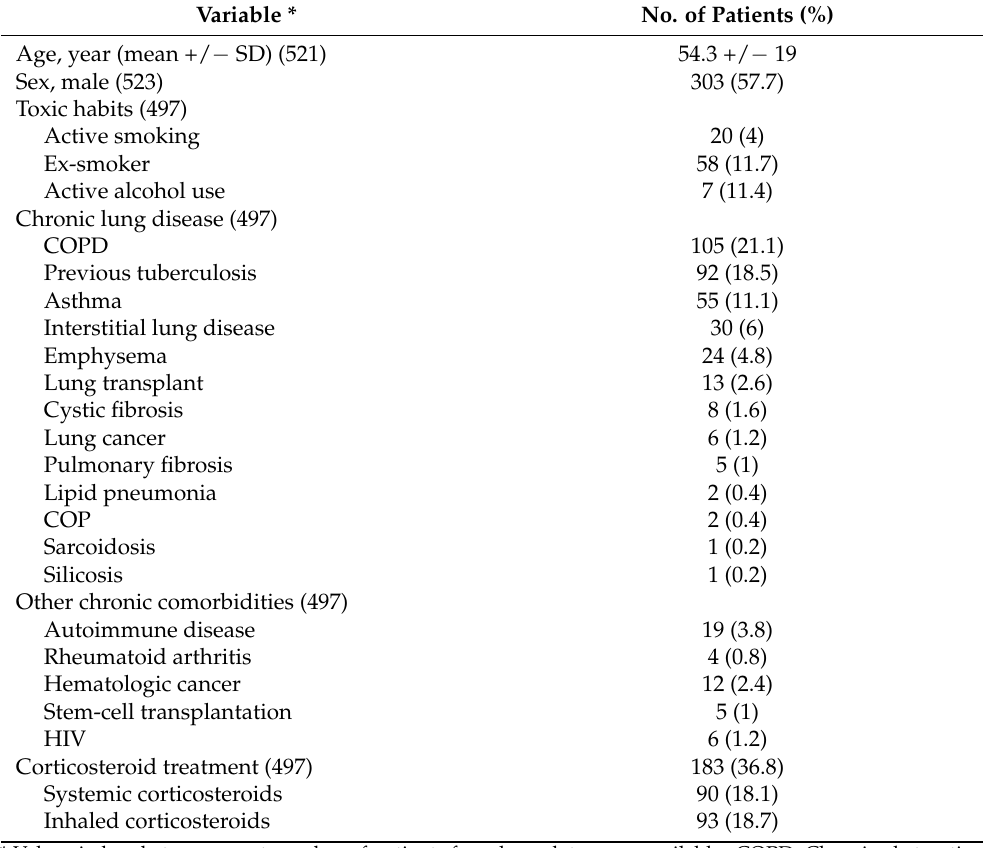
Table 1. Demographics and Underlying Conditions in patients with NTM and Aspergillus co-infection.